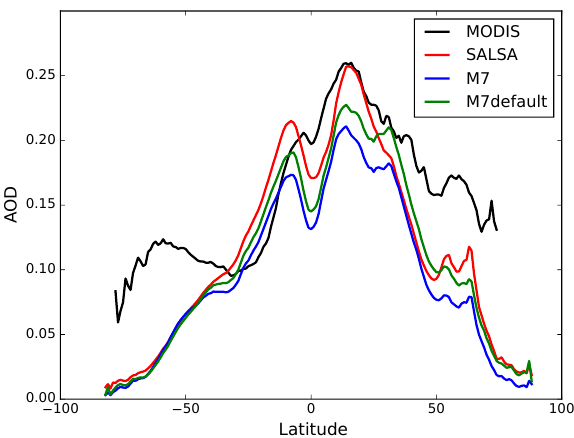
Figure 5. Zonal mean of aerosol optical depth (AOD) in year 2010 observed by MODIS (Aqua and Terra combined), SALSA2.0 (red curve), M7 (blue curve), and M7 with default wet deposition scheme (green). AOD values from MODIS at high latitudes were excluded due to the larger retrieval uncertainty at high